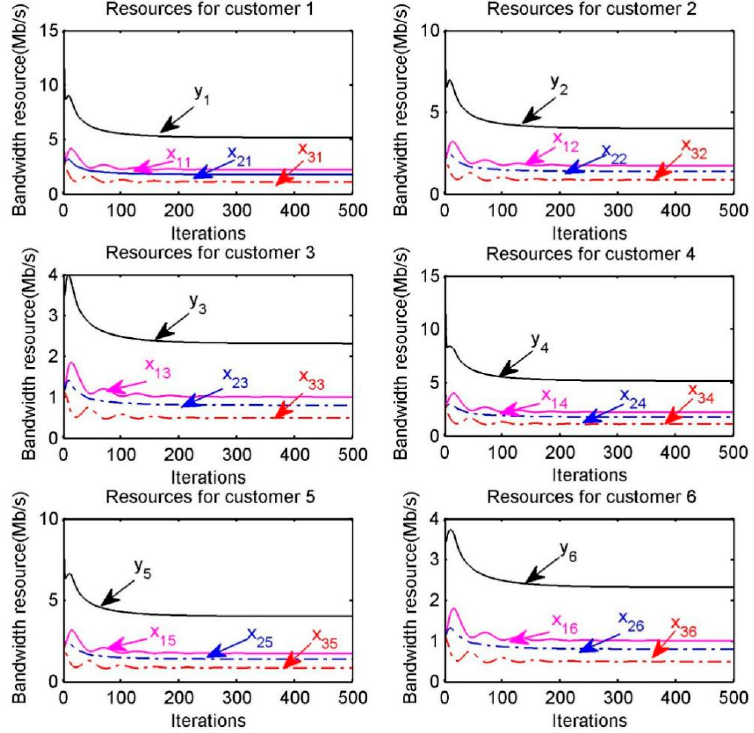
Figure 9. Performance of the resource allocation algorithm for customer r : Utility.